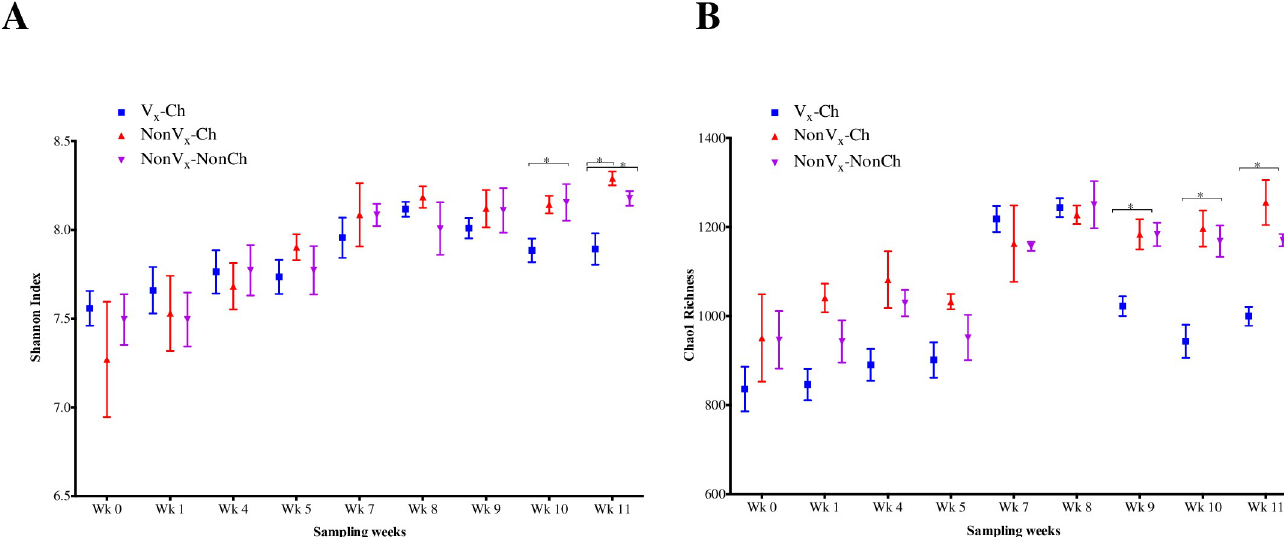
Fig 3. Alpha-diversity represented as scatter plots of the (A) Shannon Index and (B) Chao 1 species richness estimates (mean ± SEM) for three treatment groups: vaccinated and challenged (Vx-Ch), non-vaccinated and challenged (NonVx-Ch), and non-vaccinated and non-challenged (NonVx-NonCh), and for all sampling weeks. There was no significant difference in the fecal bacterial community structure between samples from the two vaccinated groups of calves (Vx E - Ch, Vx C -Ch) hence they were grouped together (Vx-Ch) for the analysis. Student’s T-test with a threshold p -value < 0.05 was considered significant.